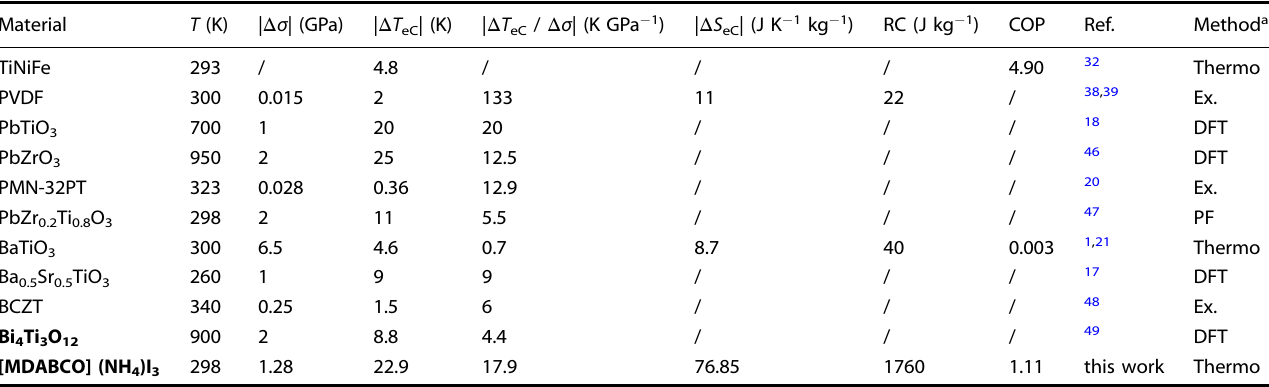
Table 1. Comparison of elastocaloric properties for different materials from previous literature and [MDABCO](NH 4 )I 3 thin fi lms in this study. Material